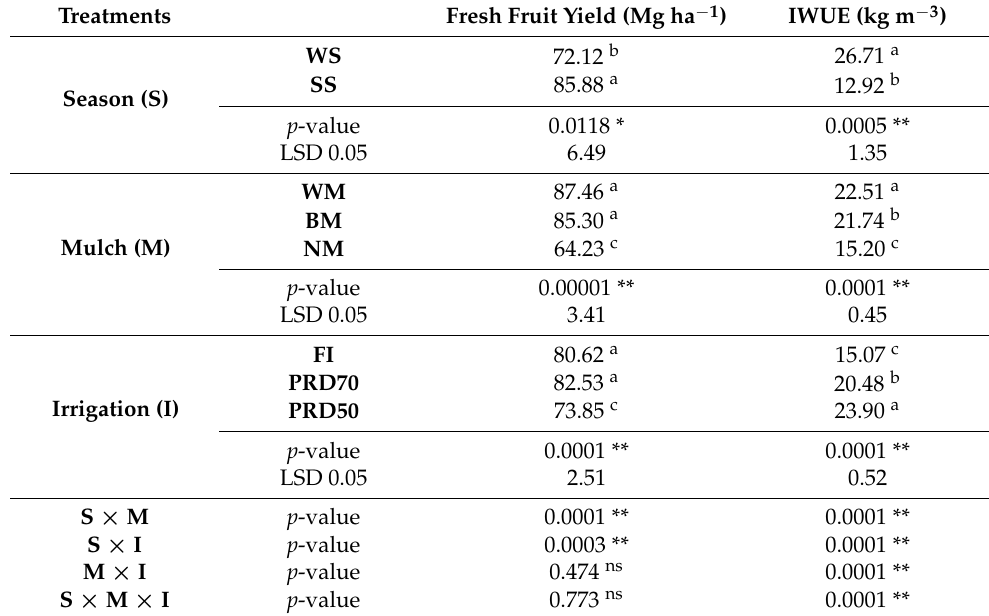
Table 5. Analysis of variance of squash fresh fruit yield and irrigation water use efficiency (IWUE) for winter (WS) and spring (SS) growing seasons.